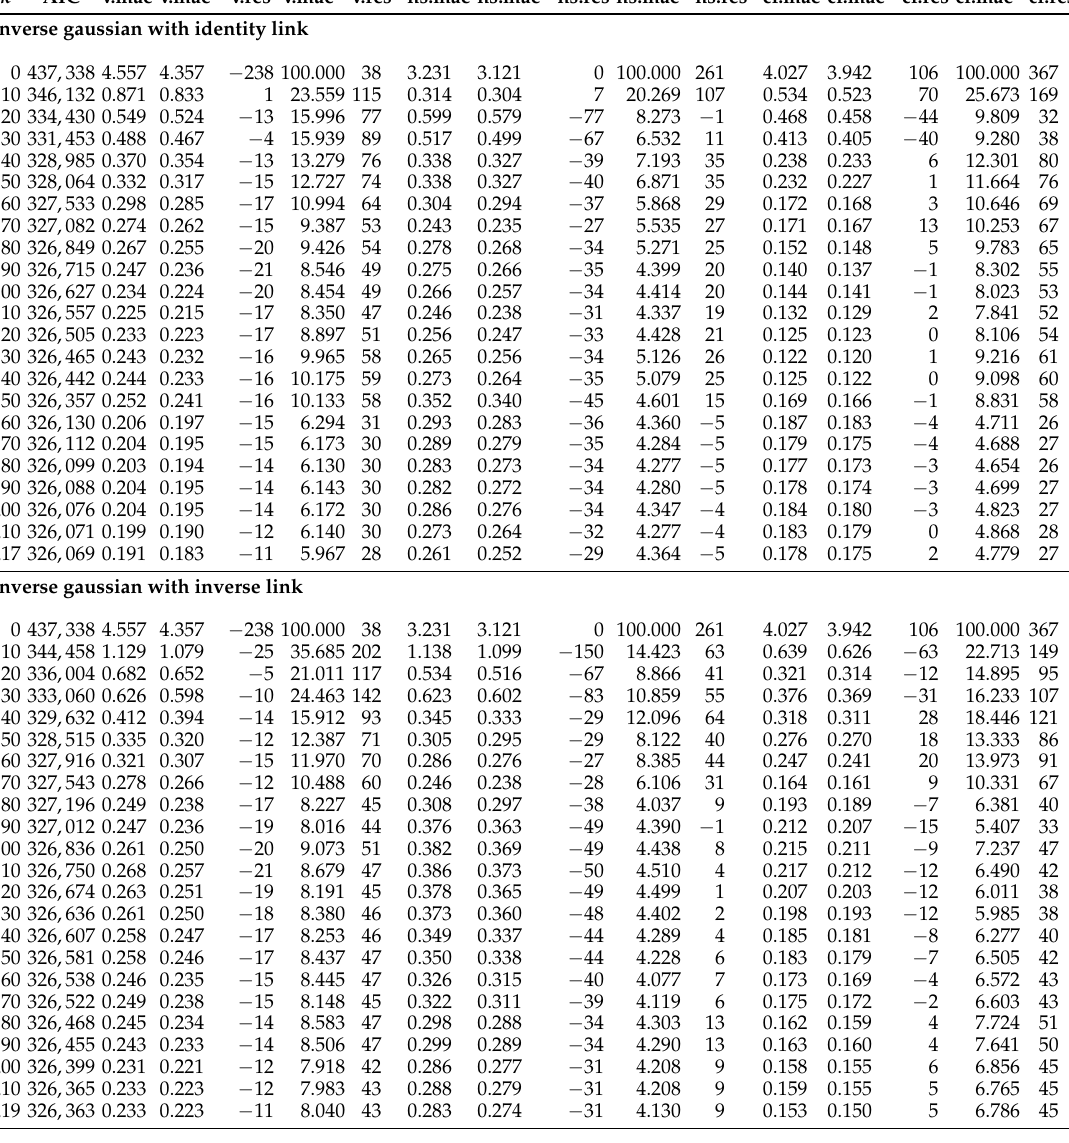
link functions under 300–886 after each tenth and the final iteration. µ 2